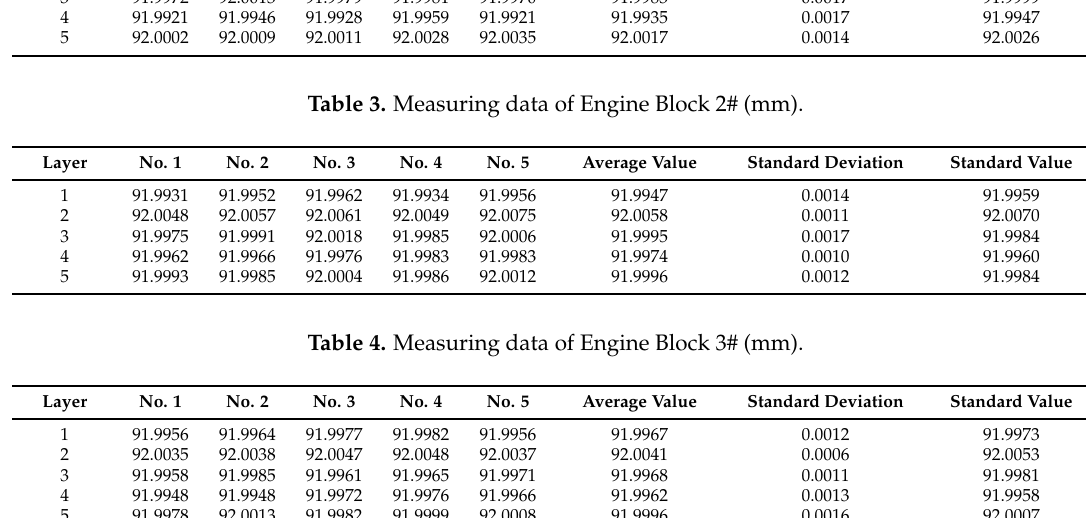
Table 4. Measuring data of Engine Block 3# (mm).